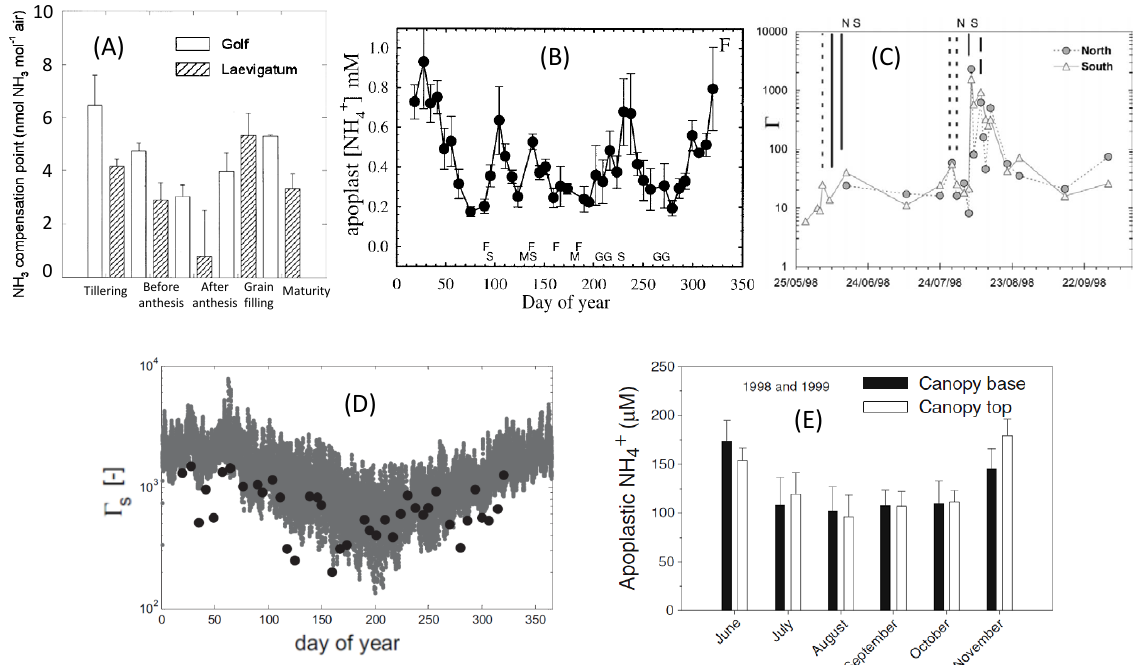
Fig. 2. Seasonal variations of: (A) stomatal compensation point in Hordeum vulgare (Husted et al., 1996); (B) apoplastic [NH + ] in fertilized 4 and grazed Lolium perenne grassland (van Hove et al., 2002); (C) apoplastic 0 s in fertilized and grazed Lolium perenne grassland in two adjacent fields (North and South) (Loubet et al., 2002); (D) apoplastic 0 s in Lolium perenne / Poa trivialis grassland (Wichink Kruit et al., 2010); and (E) apoplastic [NH + ] in Fagus sylvatica (Wang et al., 2011). In (B) , F and S indicate application of artificial fertilizer (calcium 4 nitrate) and slurry, respectively; M mowing and G grazing by cows. In (C) , vertical lines indicate management events: dotted lines = cut; bold line = fertilization; bold dashed lines = grazing. The 0 symbol represents the ratio [NH + ]/[H + 4